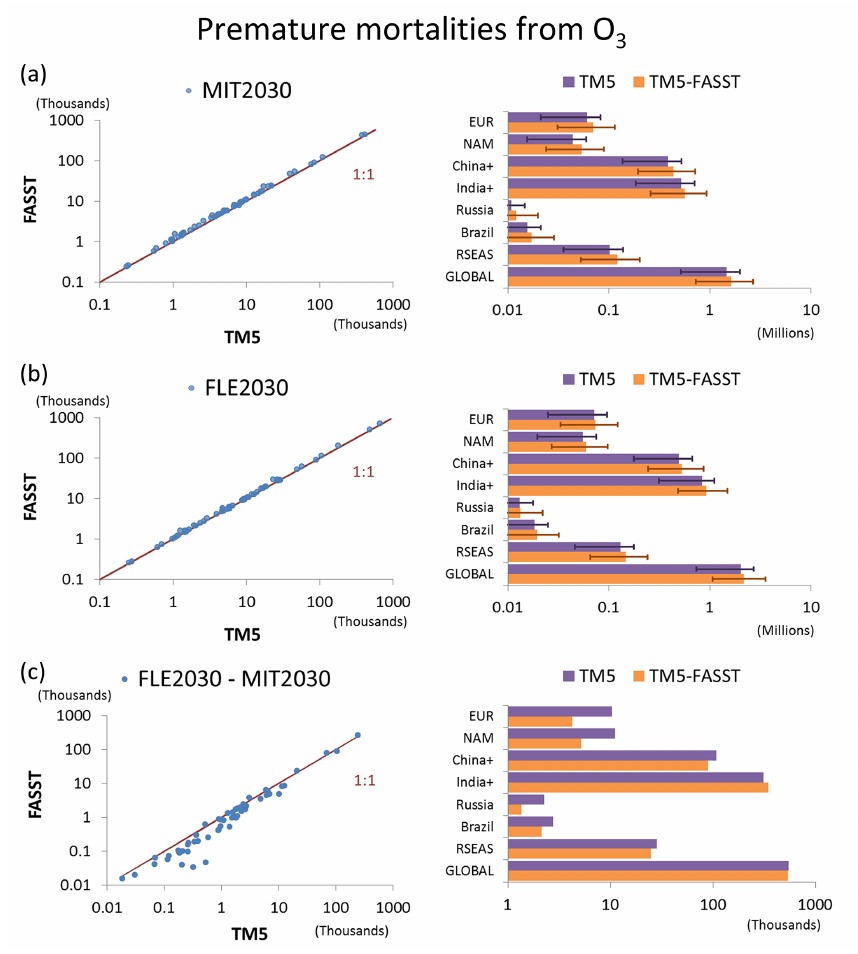
Figure 13. FASST versus TM5 premature mortalities from exposure to O 3 for MIT2030 (a) and FLE2030 (b) scenarios and the delta between both (c) . Dots show values aggregated over each FASST region. Bar plots show totals for selected world regions and the global total. Error bars represent the 95% CI on the exposure-response function (Jerrett et al.,